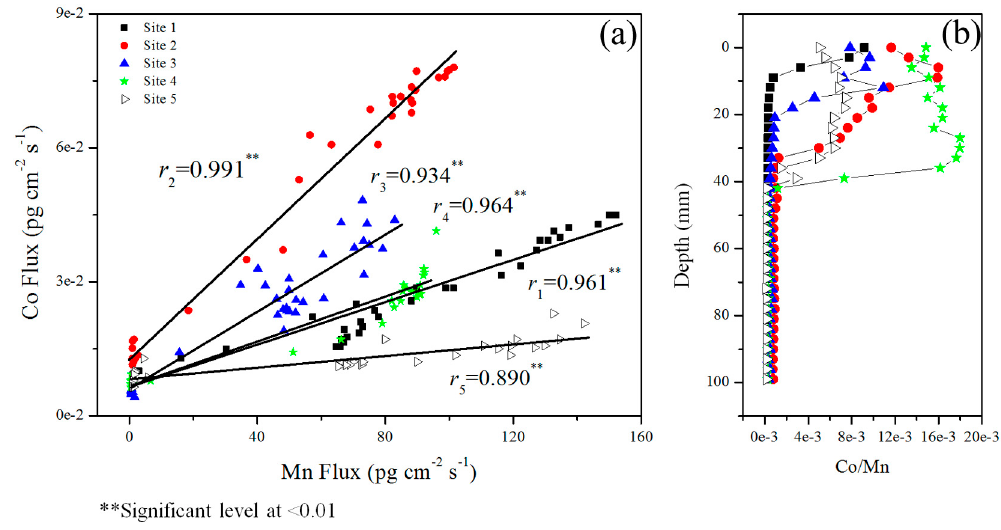
Figure 6. Correlation analysis between DGT-labile Co and Mn in sediments ( a ) and the changes of their ratio with sediment depth ( b ).